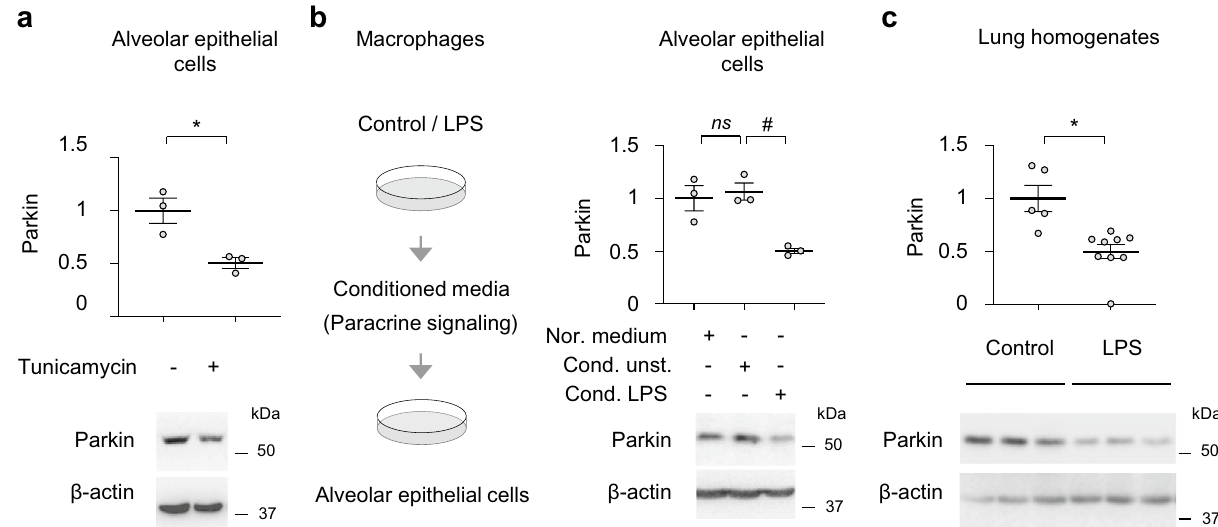
Figure 2. Parkin degradation in AECs is induced by ER stress and paracrine signaling from activated macrophages. ( a ) Representative Western Blots and optical band densitometry show Parkin protein levels in AECs Type I that were treated with Tunicamycin (0 or 10 μg/ml) for 24 h. ( b ) ( left ) Outline of experimental design to establish the impact of macrophage paracrine signaling on Parkin levels in AECs, and ( right ) representative Western blots and quantitative analysis of Parkin in AECs treated with or without conditioned media from control and LPS-treated macrophages. ( c ) Parkin levels in lung homogenates from control or mice treated with LPS ( i.t. ) for 24 h. ( a – c ) Data presented as mean ± s.e.m., ( a,b ) n = 3, and ( c ) n = 5–9. * P < 0.05, Student’s t -test; # P < 0.05, ns not significant,